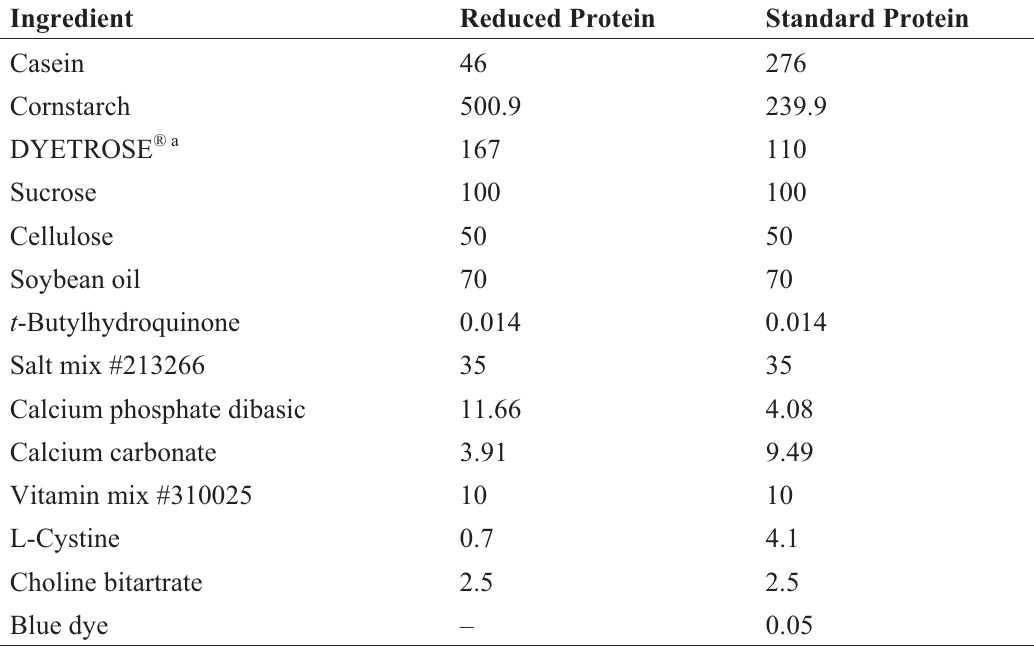
Table 1. Contents by weight (g/kg) of reduced protein (SP) and standard protein (SP) diets. Table adopted from [1]. Diets were isocaloric, each providing 3.4